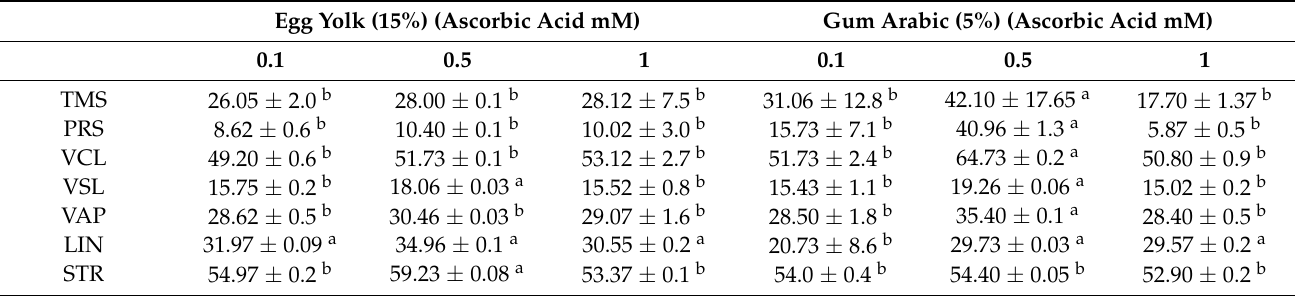
Table 4. Spermatozoa motility and viability parameters (mean ± SEM) in egg yolk and gum arabic extenders supplemented with different concentrations of ascorbic acid (0.1, 0.5 and 1 mM) and stored by deep freezing at − 196 ◦